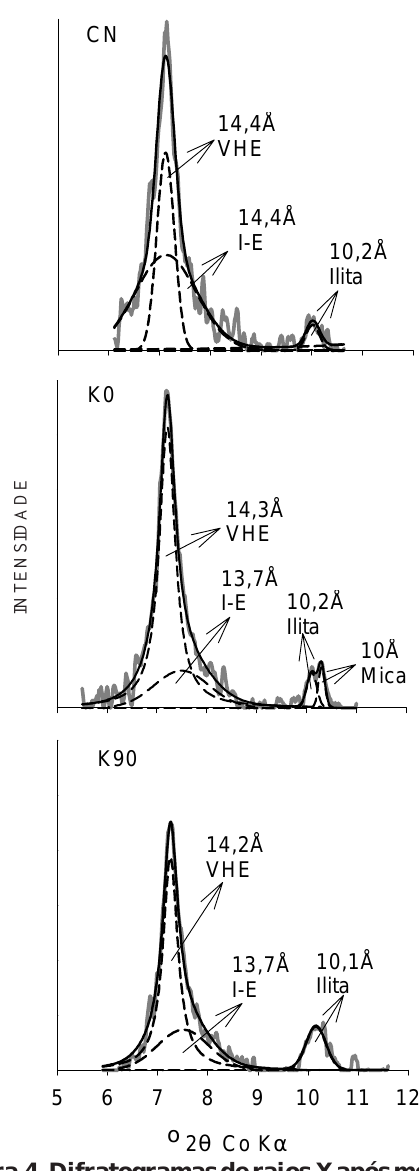
Figura 4. Difratogramas de raios X após modelagem matemática pelo programa de computador DecompXR, entre os ângulos 5 e 12 o de 2 θθθθθ , obtidos sob condição normal (25 o C) a partir de amostras da fração menor que 2 µm dos tratamentos CN, K0 e K90, Santa Maria (RS), 2005. A linha cheia clara ( ) é a curva experimental do difratograma bruto, a linha cheia escura ( ) é a curva ajustada pelo DecompXR e a linha pontilhada (- - - -) é a curva elementar de cada fase mineral. VHE = vermiculita hidróxi-Al entrecamadas; I-E = interestratificado do tipo ilita esmectita.